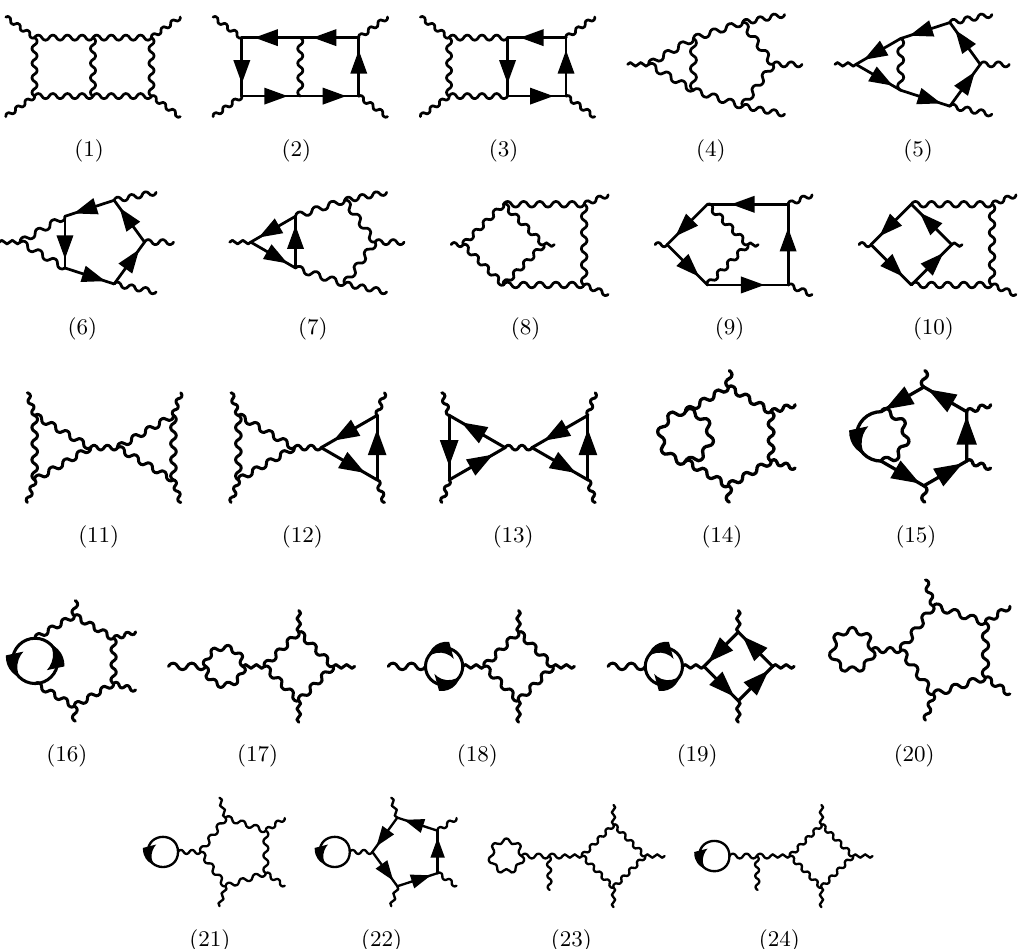
Figure 5 . A complete list of non-vanishing graphs and graphs corresponding to master numerators. The eight master graphs that we choose to work with are (1){(5), (13), (19) and (22). While tadpoles and external bubbles are dropped from the (cid:12)nal amplitudes it is useful to consider them at intermediate steps of the